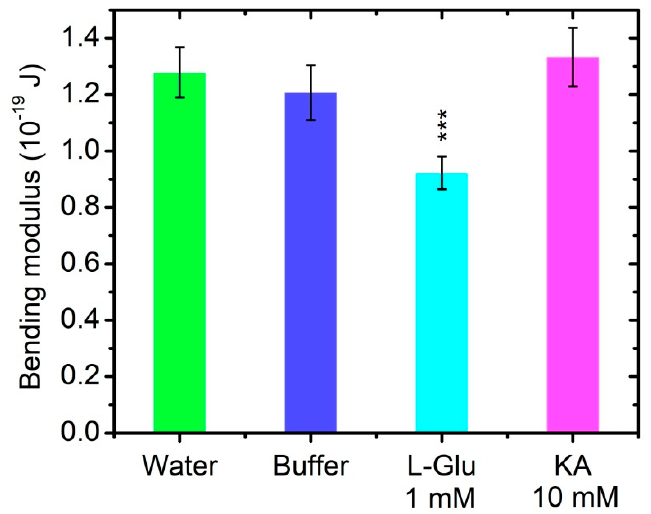
Figure 7. Bending modulus of POPC bilayers in 0.05 M Tris-HCl buffer, pH 7.2 in the presence of 1 1 mmol/L L-Glu (*** p < 0.001) or 10 mmol/L KA (n.s.) at (37 ± 0.1) ◦ C. The bending modulus is mmol/L L-Glu (*** p < 0.001) or 10 mmol/L KA (n.s.) at (37 ± 0.1) ℃ . The bending modulus is